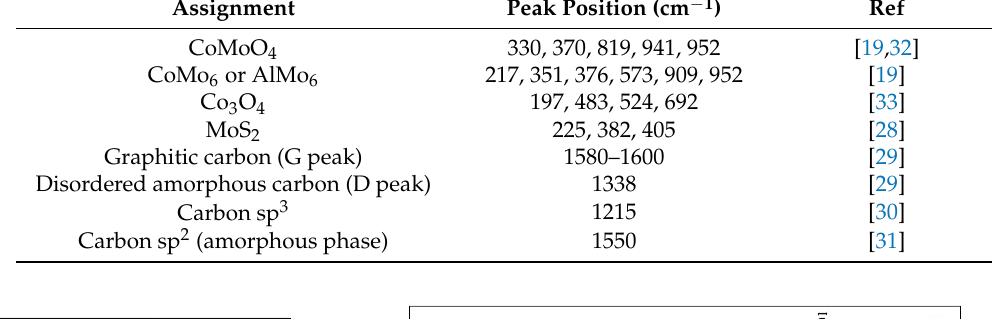
Figure 4. Raman spectrum of the spent catalyst ( a ) before and after NTP treatment carried out at 7 W at 200 ◦ C during 5 ( b ), 10 ( c ) 40 ( d ), and 60 ( e ) min. Table 2. Raman peak positions and assignment of major vibrational bands.